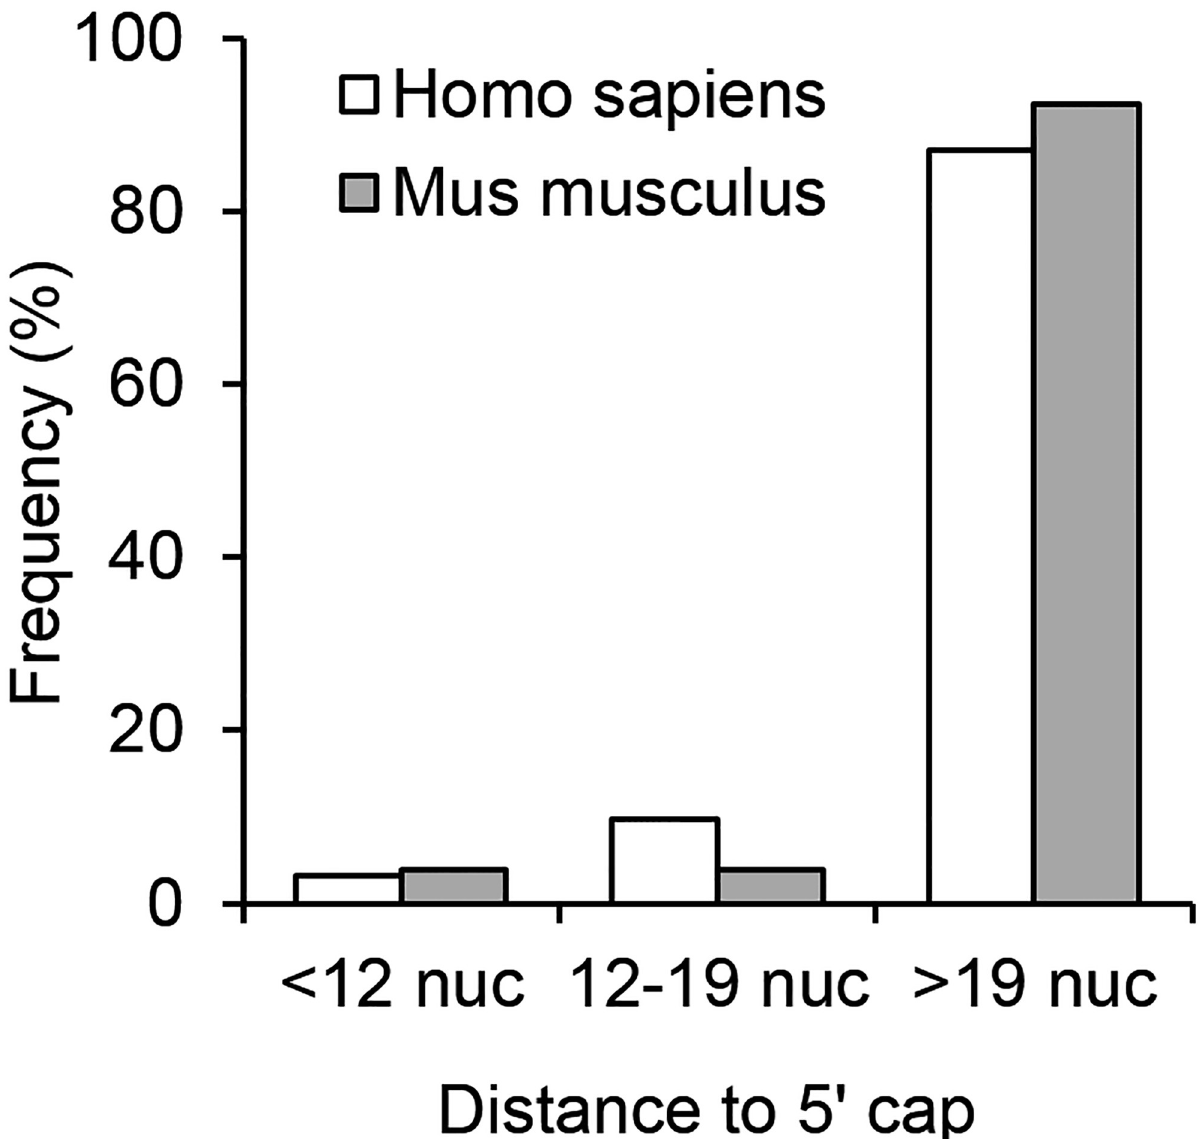
Fig 6. Translation efficiency predictions for human and mouse Lipocalins. Predictions are based in the frequency distribution of distances between the 5’ cap and each uORF present in Lipocalins 5’ UTRs.